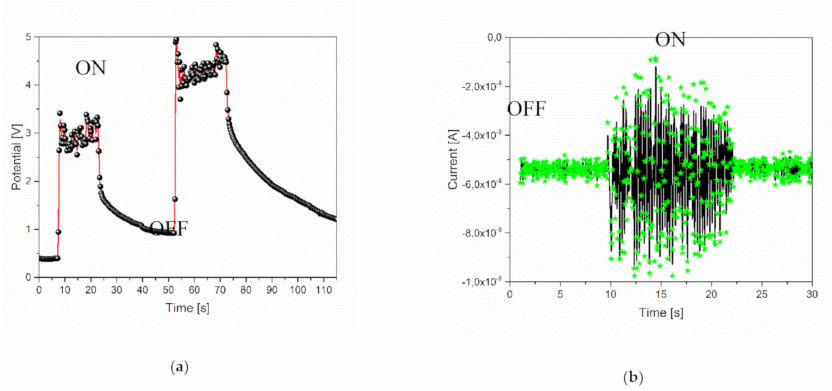
Figure 3. Evidence of triboelectric e ff ect from: ( a ) voltage-time and ( b ) current-time analysis of 1% TiO 2